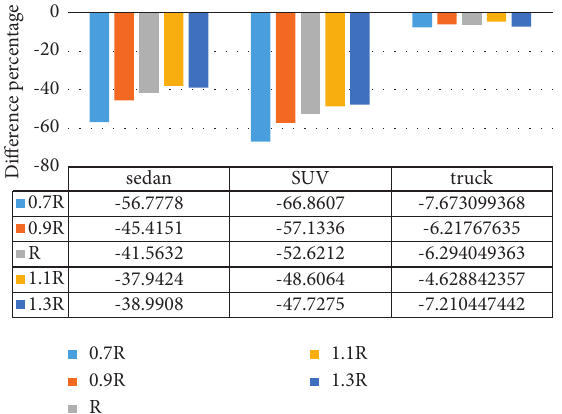
Figure 25: Difference percentage between the lateral distance in the simple and spiral horizontal curves with respect to the simple horizontal curve for various radii and at the speed of 100km/h.